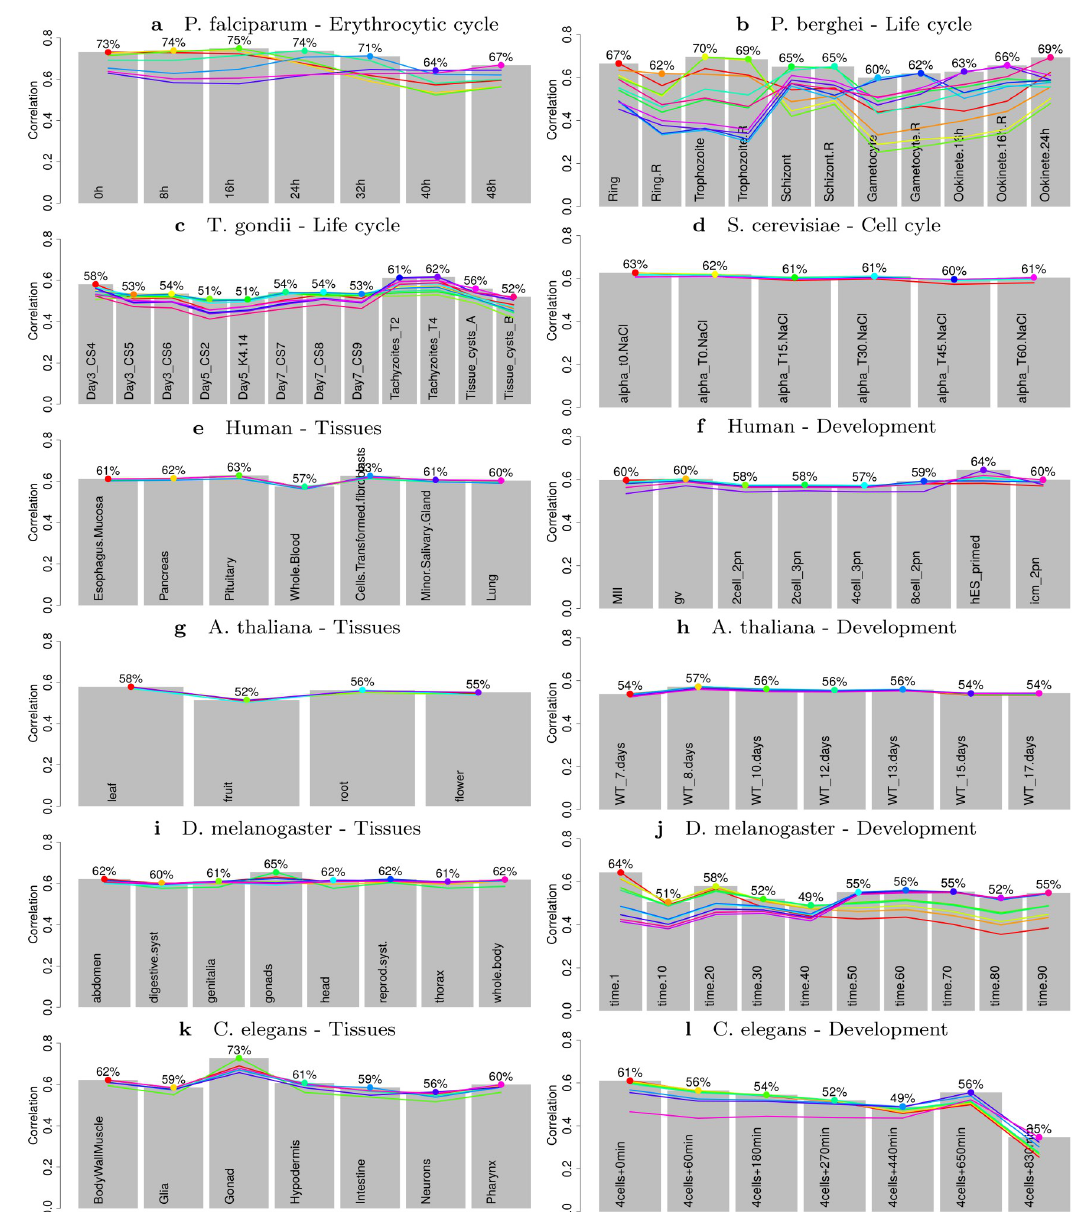
Fig 2. Accuracy of the DExTER models for predicting coding-gene expression in different species and conditions. Grey charts represent the accuracy, measured as the correlation between predicted and observed gene expression, of the models learned on different conditions. Colored curves summarize the accuracy of a model learned on a specific condition (identified by a big dot of the same color) when used to predict the other conditions of the same series.